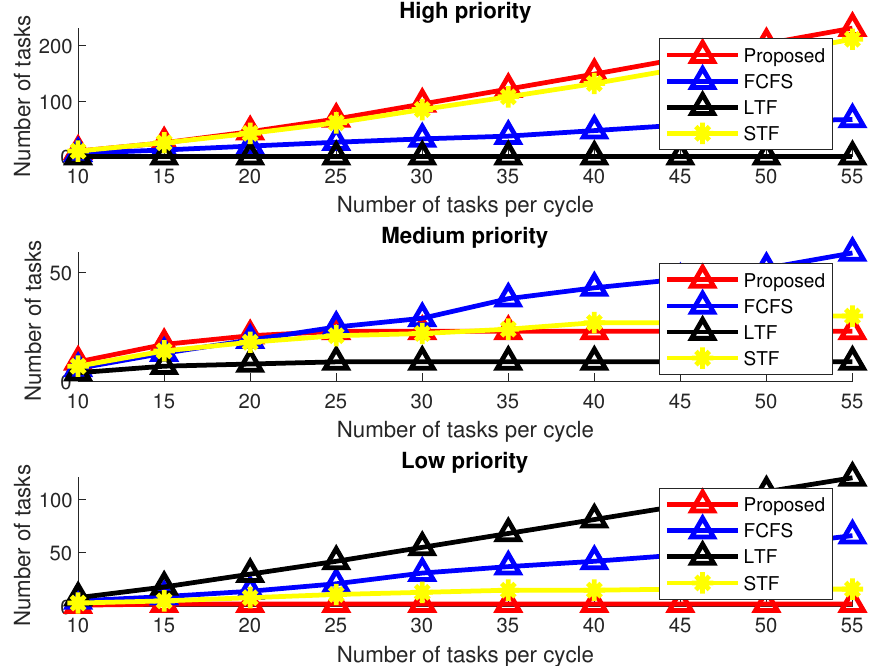
Figure 5. Number of tasks performed by fog nodes for varying number of